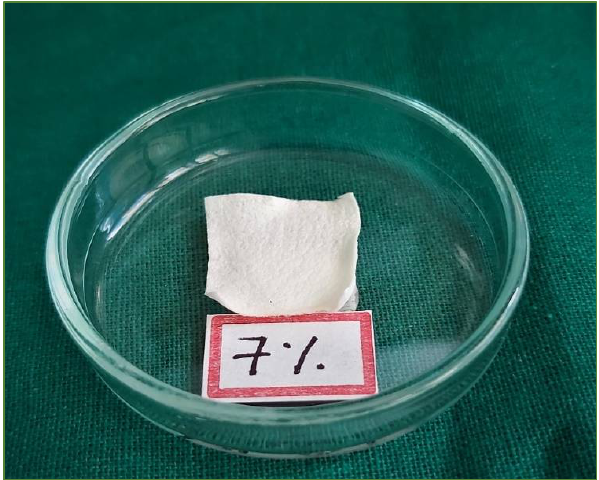
Figure 2. Calendula officinalis loaded gelatin